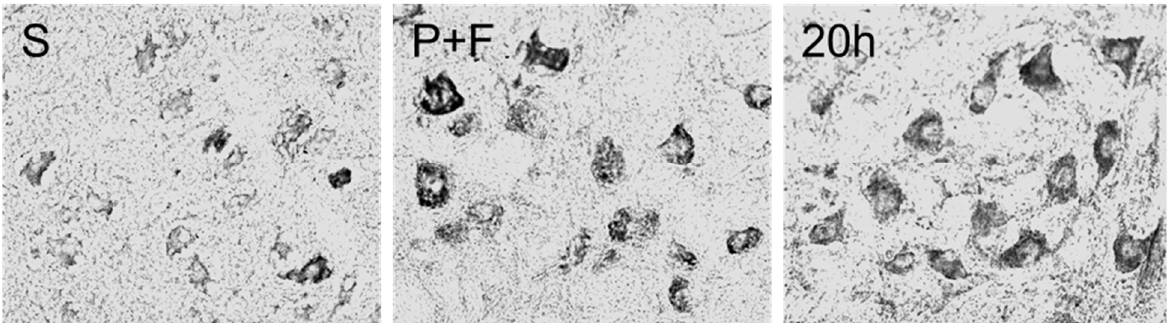
Figure A14. Dopamine β -hydroxylase immunoreactivity in area 7 of the brainstem of Syrian hamsters. Comparison between sleep (S, group 5), sexual stimulation with pheromone and females (P+F, group 1), and 20 h manual sleep deprivation (20 h, group 3c). Magnification: 200×.